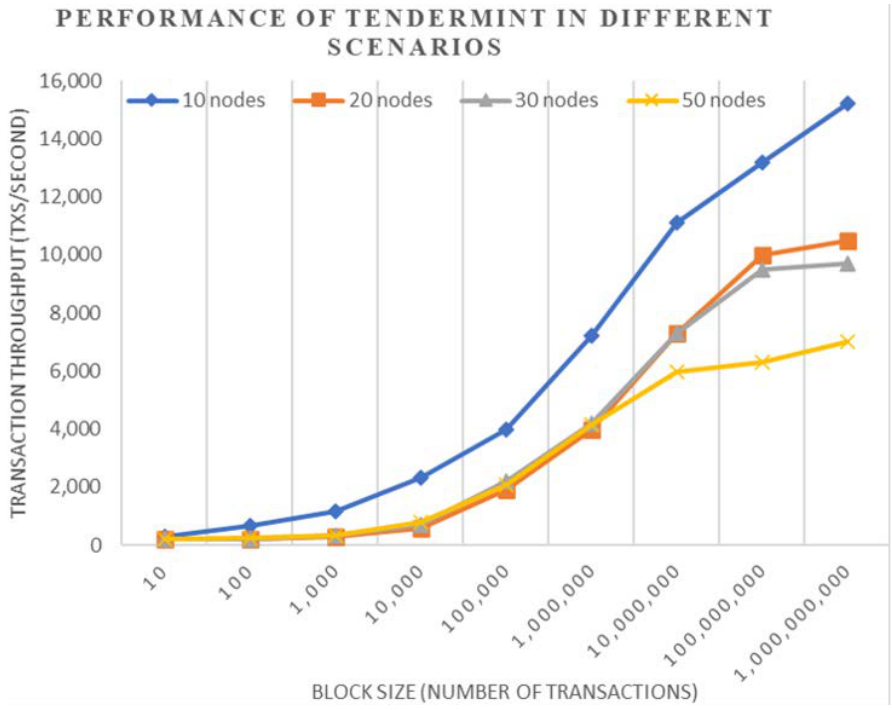
Figure 6. Performance of